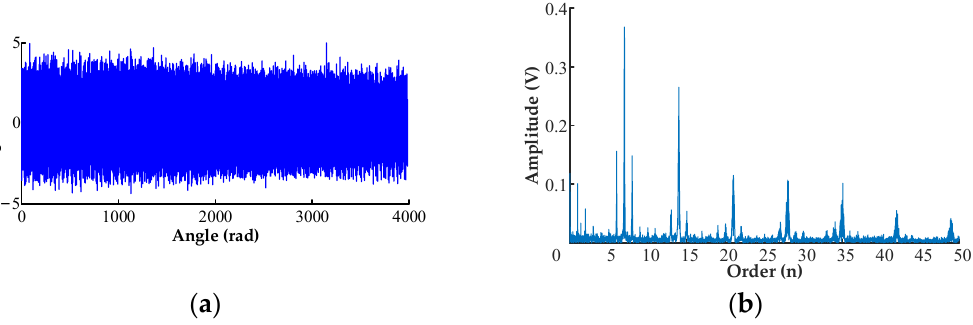
Figure 10. ( a ) Angular domain vibration signal in severe wear state; ( b ) Order spectrogram in severe wear state.